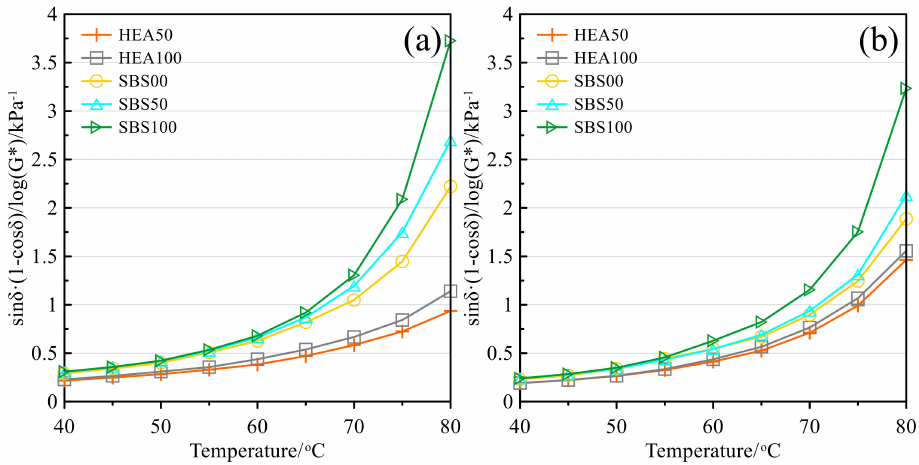
Figure 8. Viscoelastic index Z: ( a ) Before TFOT; ( b ) After